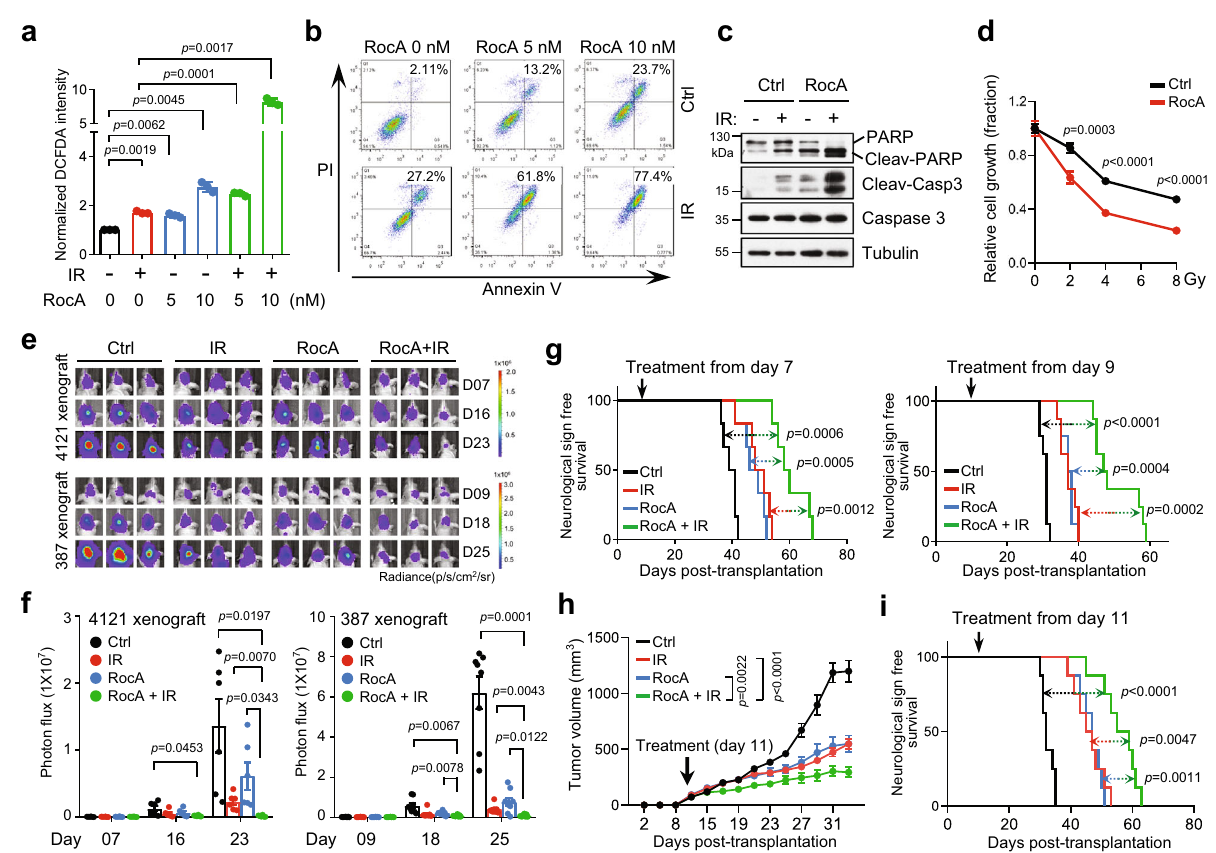
Fig. 7 Pharmacological targeting PHB increases sensitiveness of GSCs to IR. a The peroxide levels, as indicated by DCFDA fl uorescence, were measured by fl ow cytometry in 4121 GSCs with indicated treatment for 48 h. IR, 3 Gy (mean ± SD, n = 3, biologically independent experiments, Welch ’ s two-sided t- test). b Cell apoptosis was measured by fl ow cytometry in 4121 GSCs with indicated treatments for 48 h. IR, 3 Gy. c IB showing levels of